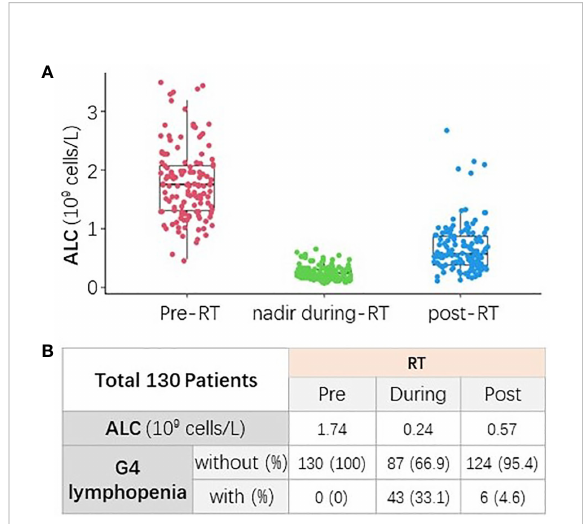
FIGURE 1 The change of absolute lymphocyte count (ALC) from baseline to post- RT. (A) ALC declined during RT and generally recovered to some extent at the completion of RT. (B) The median ALC and incidence of G4